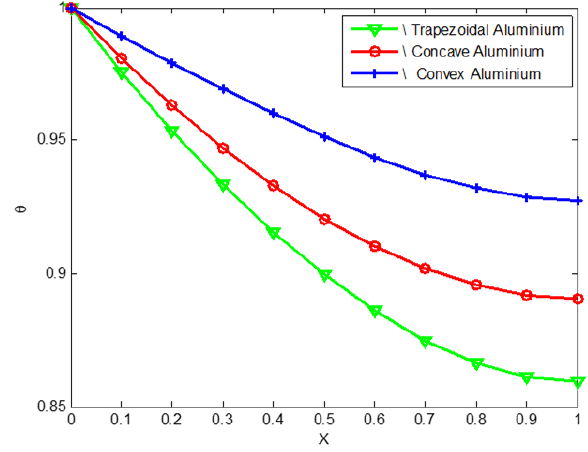
Figure 4. Effect of geometries of Aluminium porous fins on non-dimensional temperature